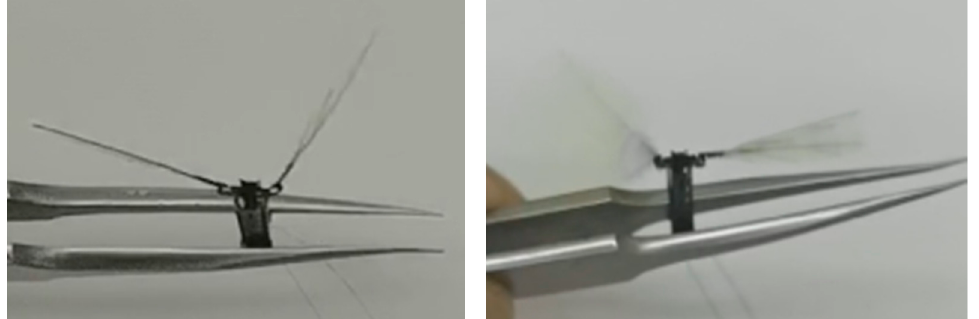
Figure 14. The two wings were driven asymmetrically.